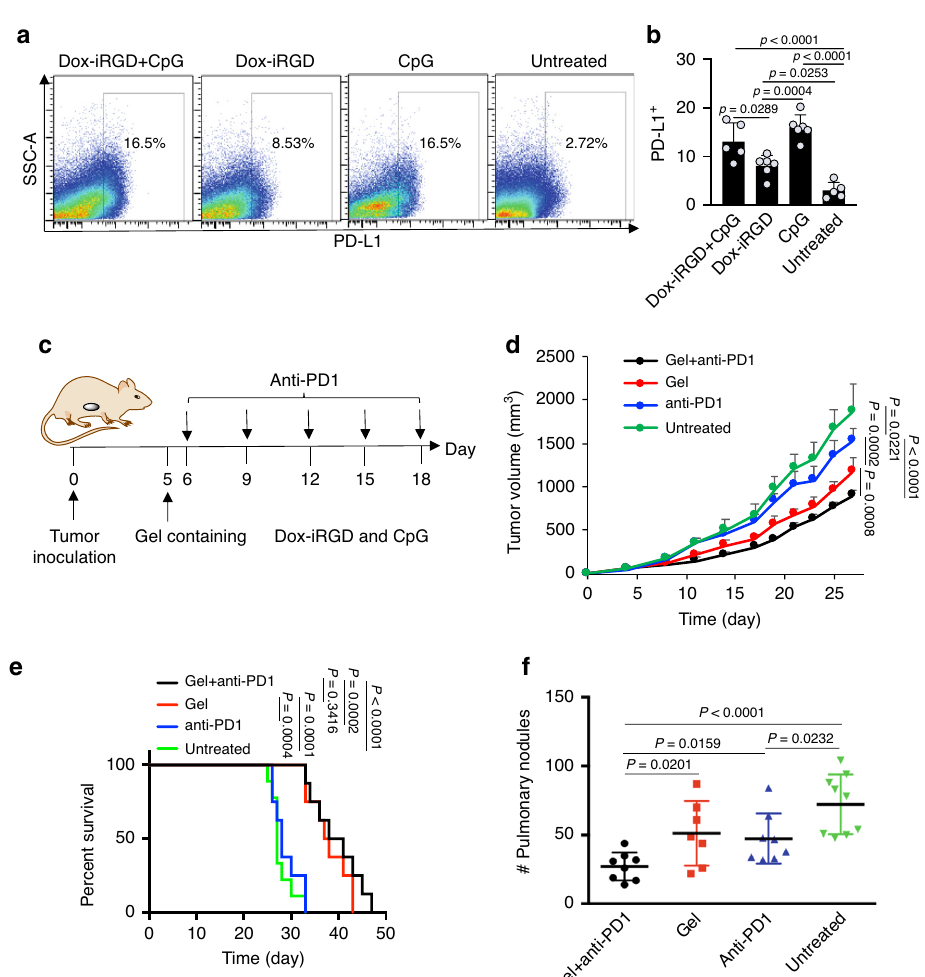
Fig. 6 In situ gel vaccine combined with anti-PD-1 therapy for tumor control. a Representative FACS plots for PD-L1 expression of tumor cells (CD11b + , CD3 + , and CD8 + cells have been excluded for these plots) and b percentage of PD-L1 + tumor cells at 11 days post treatment with gels containing Dox- iRGD (200 μ g) and CpG (100 μ g), or Dox-iRGD (200 μ g) alone or CpG (100 μ g) alone. n = 6 biologically independent animals per group. Statistical analysis was performed using ANOVA with Fisher ’ s LSD post hoc test. c Time frame of ef fi cacy study. Following 4T1 tumor inoculation on day 0, gels containing Dox-iRGD (200 μ g) and CpG (100 μ g) were injected next to tumors on day 5, and anti-PD-1 was intraperitoneally injected on days 6, 9, 12, 15, and 18, respectively. d Average 4T1 tumor volume of each group over the course of the ef fi cacy study. Statistical analysis was performed using ANOVA with Fisher ’ s LSD post hoc test. e Kaplan – Meier plots for all groups. Statistical analysis was performed using the log-rank (Mantel – Cox) test. For d , e , n = 9 biologically independent animals for the untreated group and n = 8 for the other three groups. f Average tumor nodule counts on the lung tissues harvested from mice at the time of euthanasia. n = 9 biologically independent animals for the untreated group, n = 8 for the anti-PD-1 and gel + anti-PD-1 groups, and n = 7 for the gel group. Statistical analysis was performed using ANOVA with Fisher ’ s LSD post hoc test. All the numerical data are presented as mean ± SD, except for d where mean ± SEM is used. Source data are provided as a Source Data fi